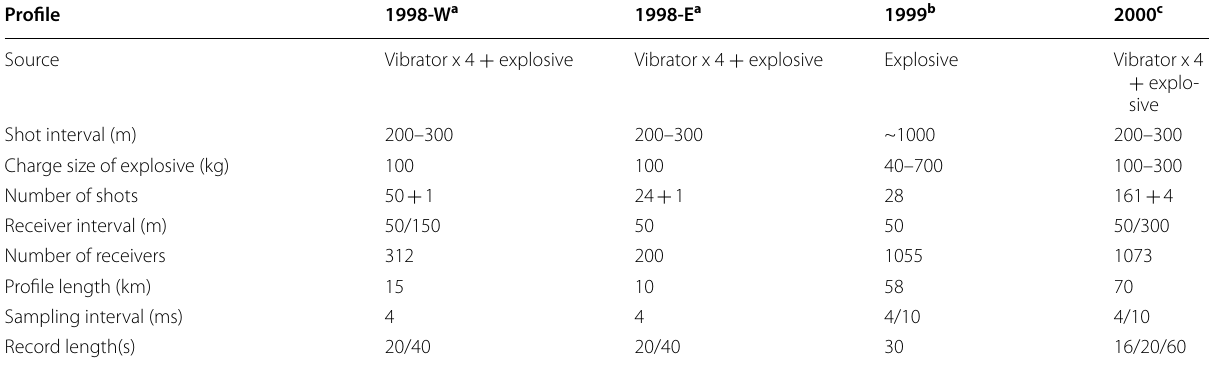
Table 1 Seismic reflection experiments in the Hokkaido Transect Project